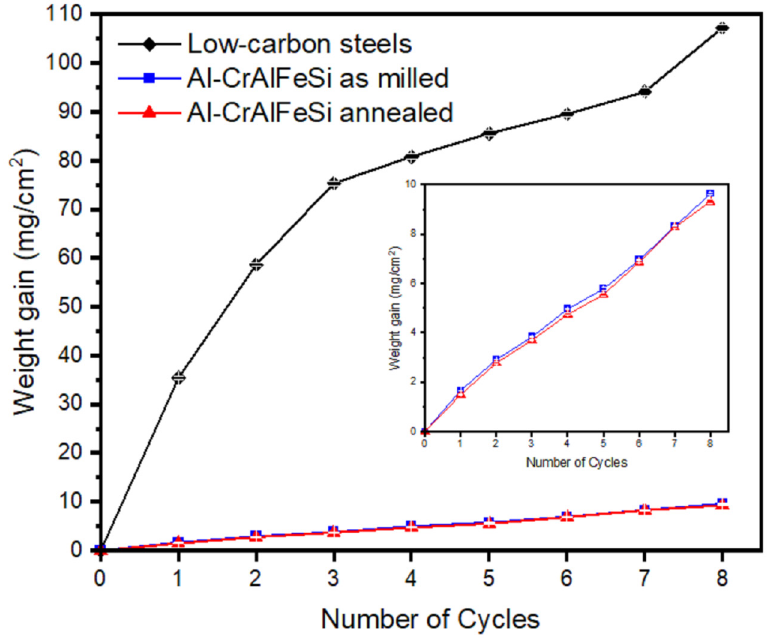
Figure 11. The cyclic oxidation curves of uncoated and coated substrate after oxidation at 800 °C for 20 h in one